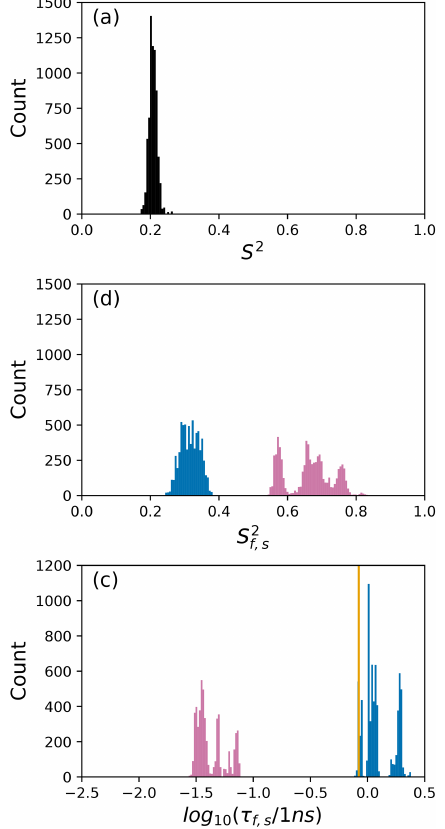
Figure 6. Distribution of model-free parameters from bootstrap ag- gregation for residue Arg 11. Color coding is S 2 purple) and S 2 s or τ s (blue). The orange line in (c) indicates the value of τ s obtained for the optimal single (unsmoothed) model, Model 4. For clarity, null values of 1 for generalized order parameters and 0 for internal effective correlation times are not shown in the graphs; τ f = 0 is observed 1664